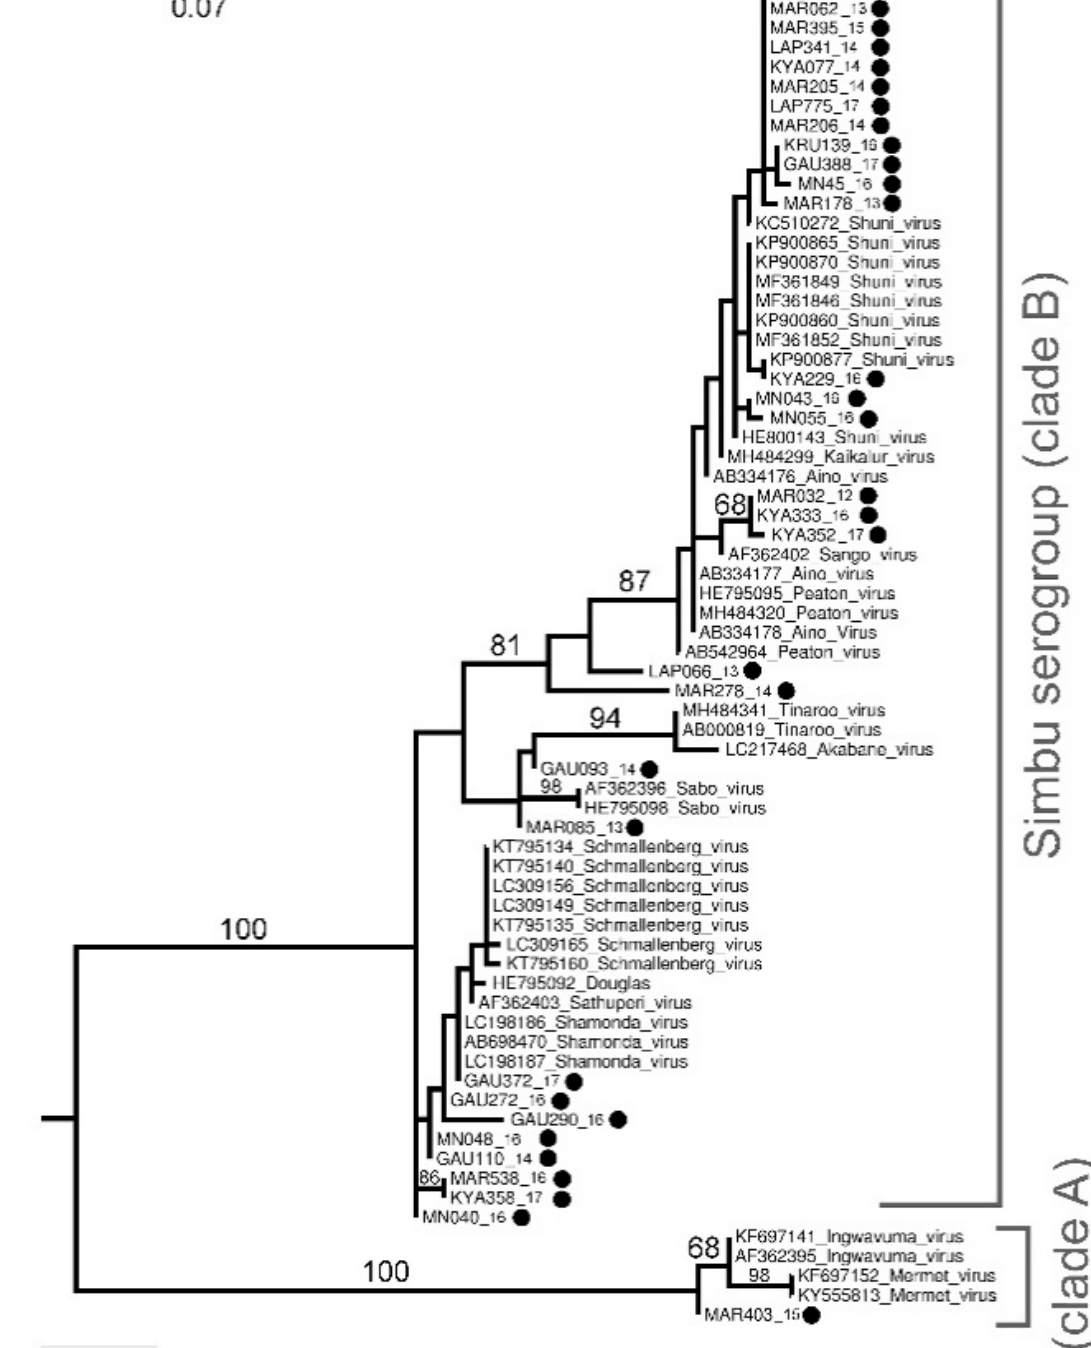
Figure 1. Maximum likelihood phylogram of the partial (nucleotides = 152, 70 taxa) Orthobunyavirus S segment. Bootstrap support (<60 omitted) calculated using autoMRE function invoked in RAxML (GTR + G model). Phylogram rooted at midpoint. Filled black circles indicate new sequences for viruses detected in this study.